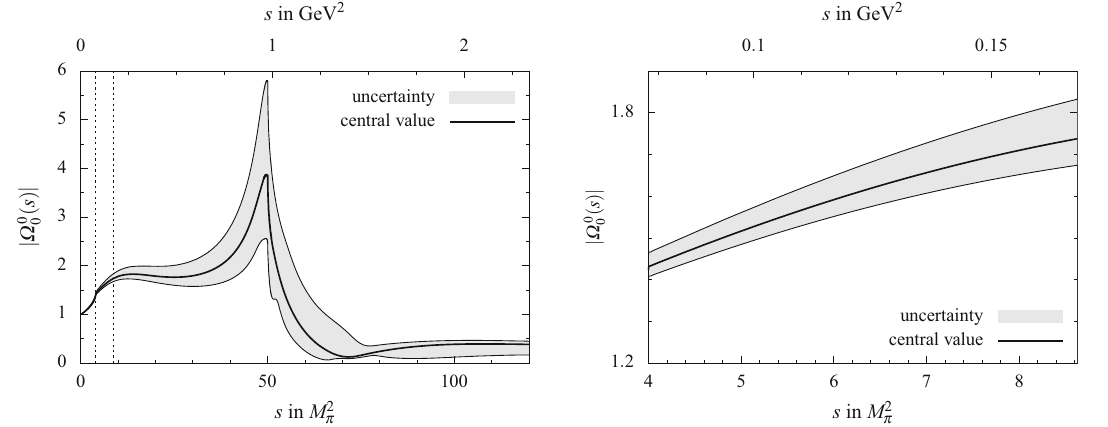
( s ) | , calculated from the ππ S -wave effective phase shift δ 0 0